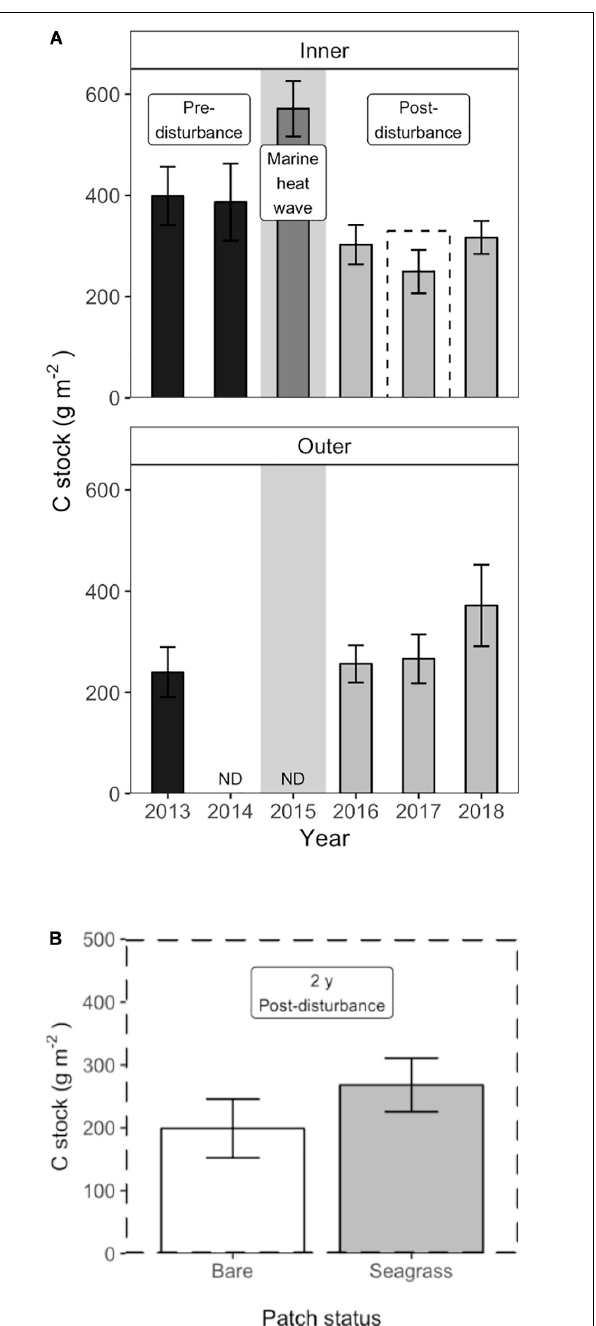
FIGURE 6 | Sediment carbon stocks at the inner and outer meadow sites; gray background indicates the year of the MHW (A) At the inner sites, a large pulse of sediment C was observed within a month of the MHW in 2015, compared to the pre-disturbance stock. Sediment C then declined rapidly following the disturbance and began re-accumulating in 2018. At the outer sites, sediment C stocks were constant before and after the disturbance and accumulated in 2018. Values are mean ± 2 × SE, outer sites: n = 9 (2013), n = 4 (2016), and n = 6 (2017–2018); inner sites: n = 6. (B) Two years after the disturbance, small (m 2 ) patches of recovering seagrass retained significantly more sediment carbon compared to bare patches at the inner sites ( n = 6, mean ± 2 ×